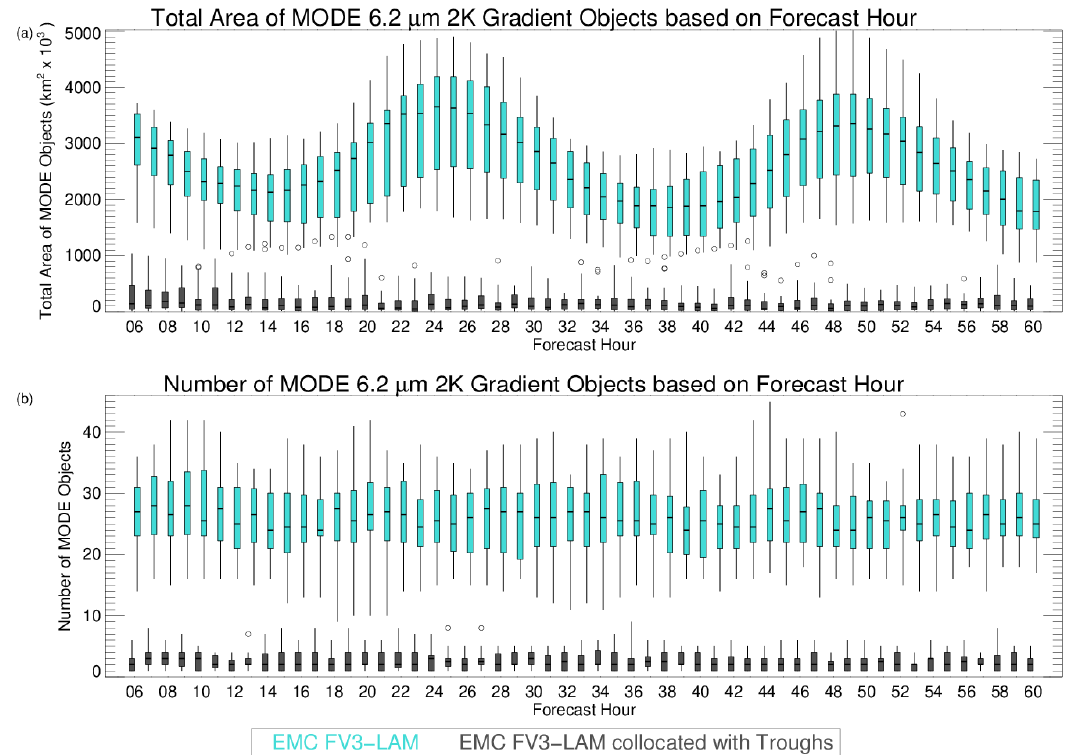
Figure 11. ( a ) Total area and ( b ) number of MODE gradient objects by forecast hour from EMC FV3-LAM (light blue) co-located with a 500 hPa trough (grey).